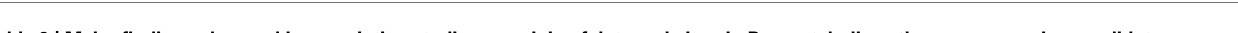
Table 3 | Major findings observed in association studies examining folate and vitamin B 12 metabolic pathway genes, using candidate gene studies, major diseases, and dietary folate or B 12 dietary intake, including sample size, significance (as p or 95% confidence interval), and risk measurement (Odds ratio, OR)